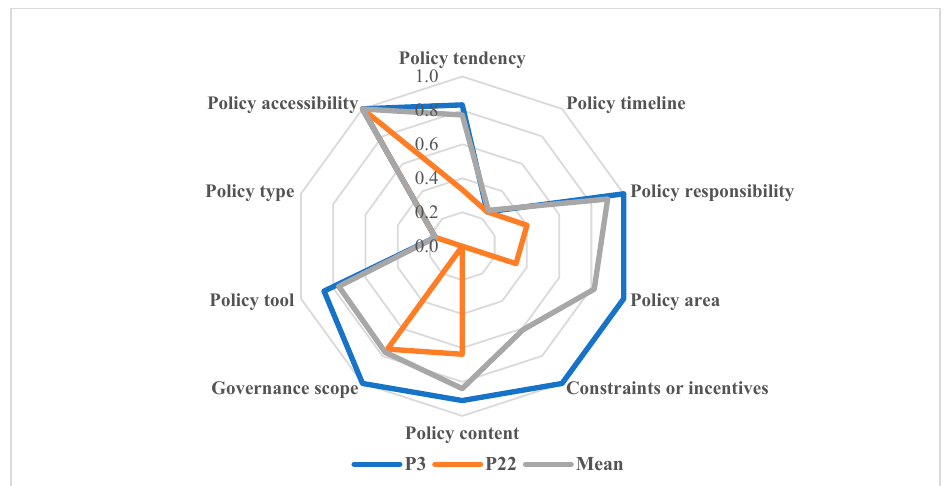
Figure 4. Radar chart comparison of P3 and P22.